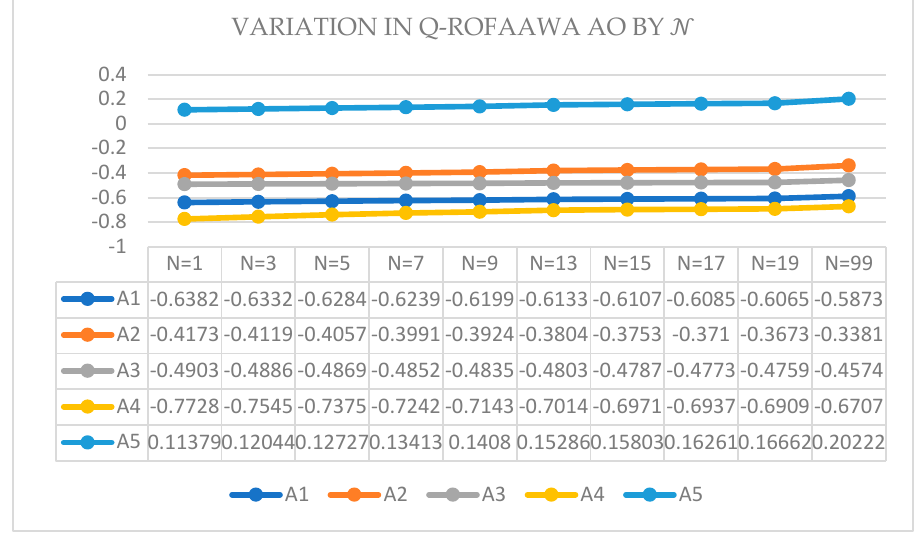
Figure 2. The graphical representation of score value, variation by 𝒩 .